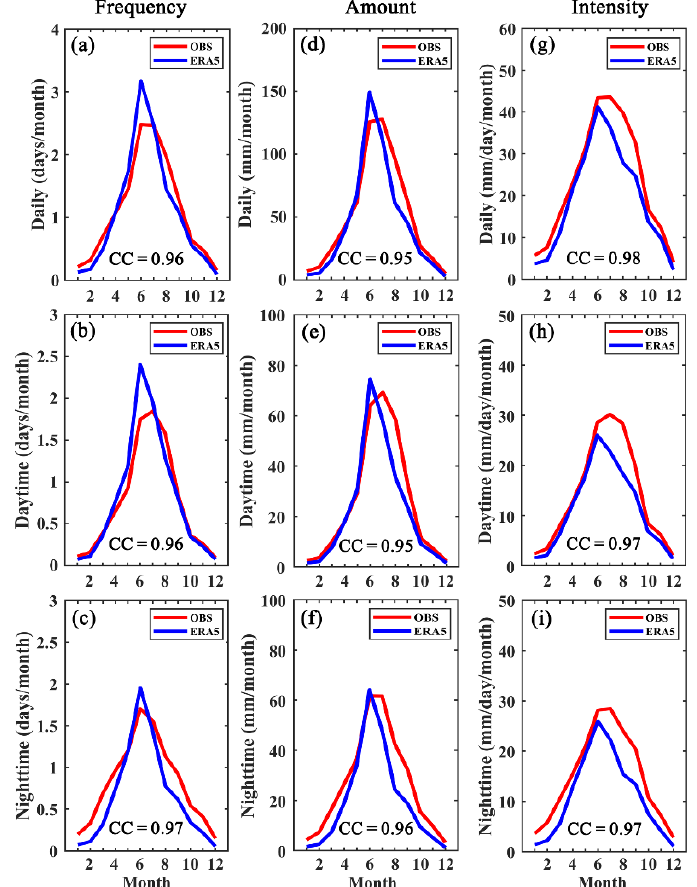
Figure 5. Seasonal cycles of extreme precipitation frequency ( a – c ), amount ( d – f ), and intensity ( g – i ) in observations (OBS, red) and their corresponding ERA5 grid points (blue) at the daily, daytime, and nighttime scales (top, middle, and bottom rows, respectively). CC denotes correlation coefficient.